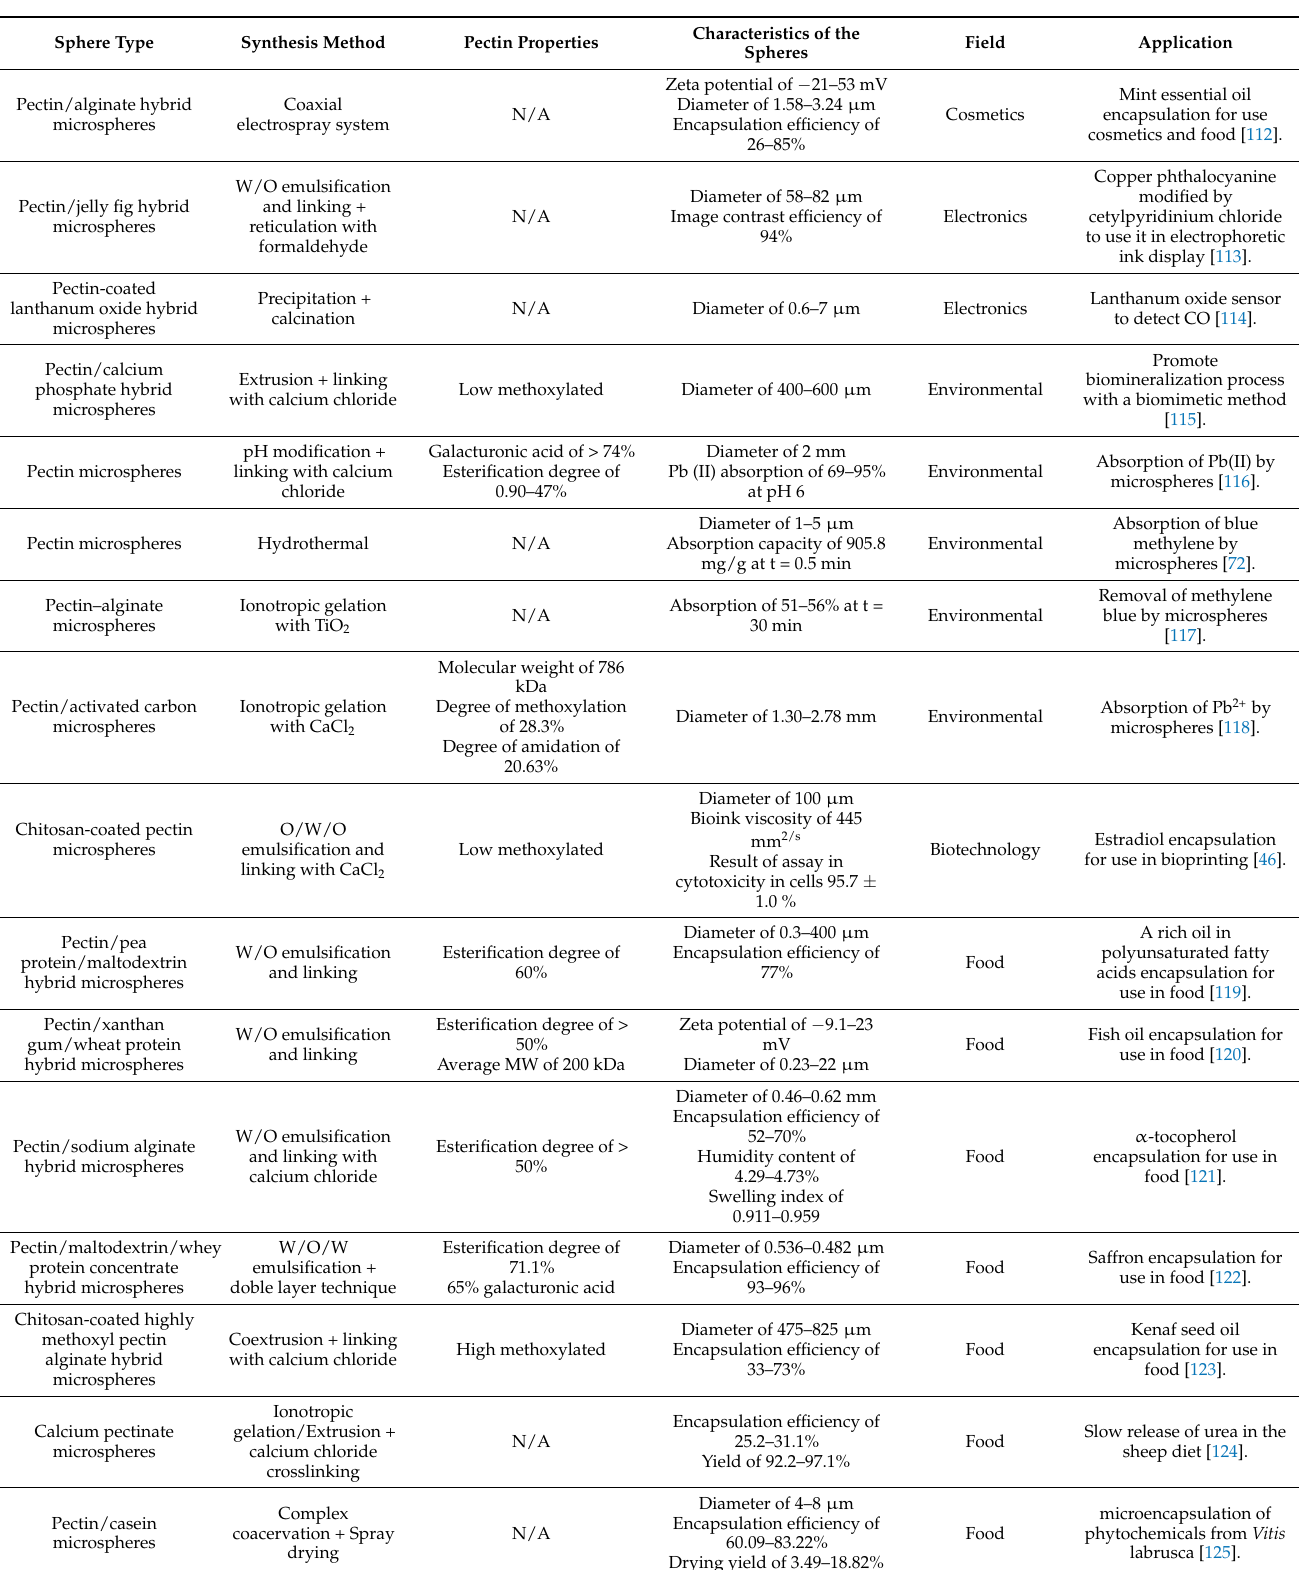
Table 2. Pectin microspheres, properties, and applications in